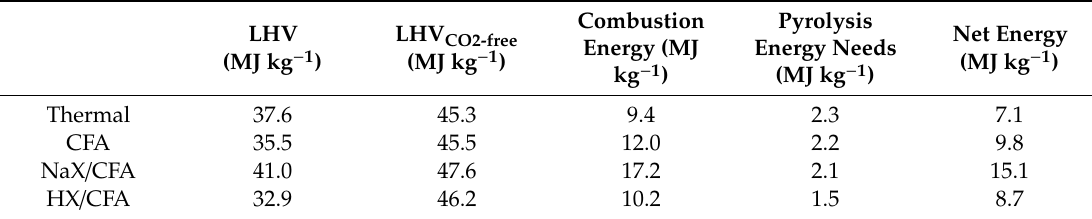
Table 5. LHV, LHV on CO 2 -free basis, and energy of combustion of the gaseous mixture produced during thermal and catalytic